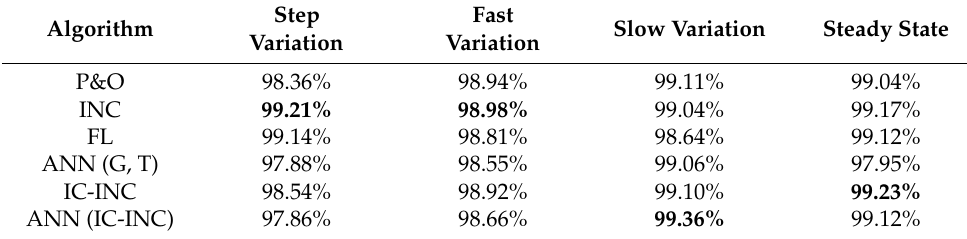
Figure 17. Simulation results of power produced from panel when slow variations occurred. Table 4. HIL results of MPPT